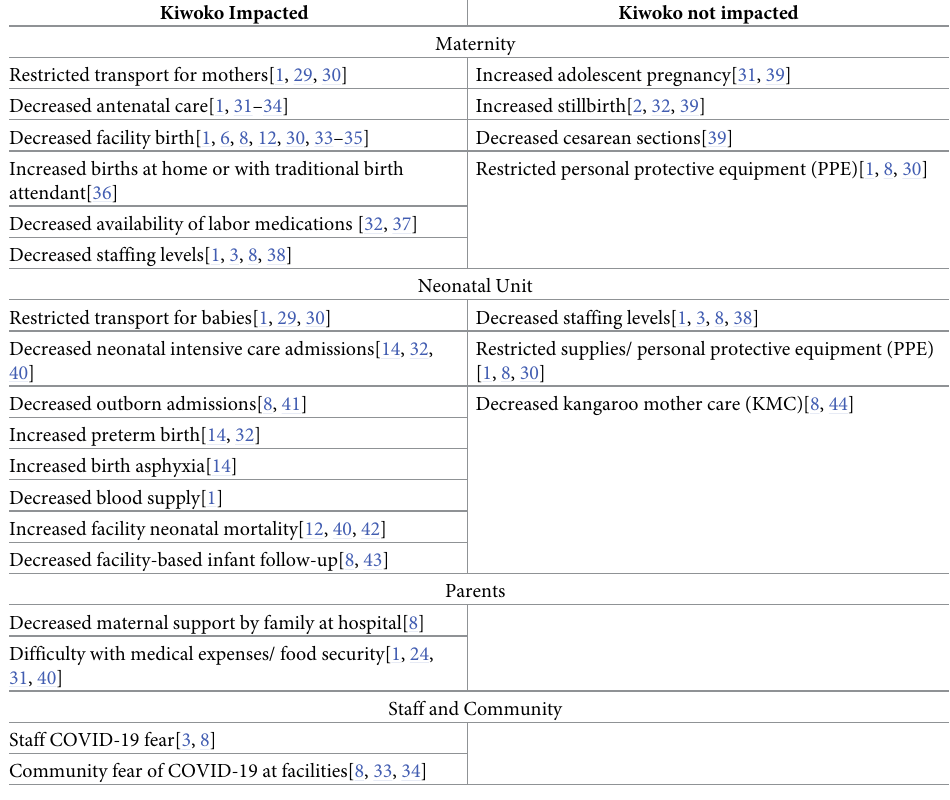
Table 4. Summary of impacts on maternal child and health reported globally during the early COVID-19 pan- demic and the experience at Kiwoko hospital. Kiwoko Impacted Kiwoko not impacted